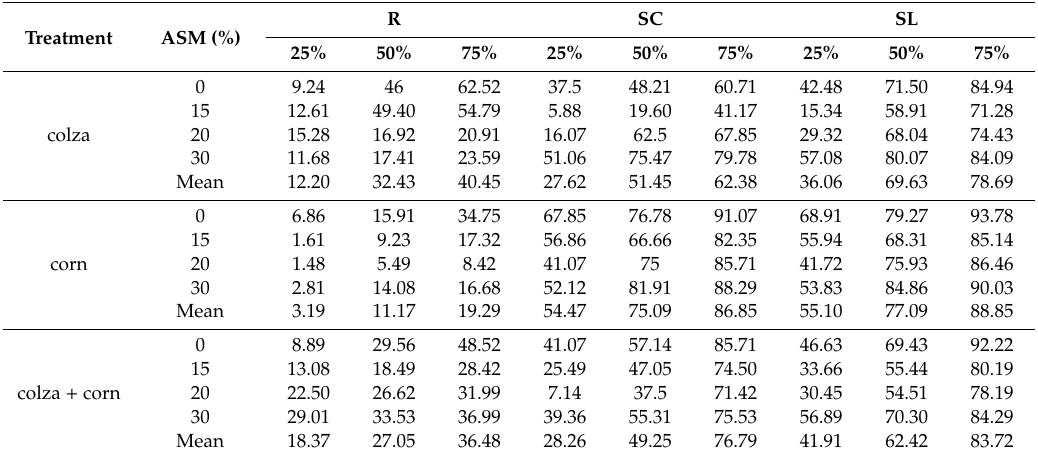
Table 3. Percentage of changes in soil erosion results after the application of colza, corn and colza + corn straw mulches, under di ff erent soil moisture level conditions. ASM, antecedent soil moisture; R, runo ff ; SC, sediment concentration; SL, soil